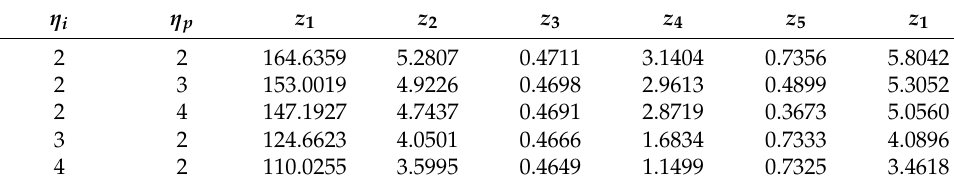
Table 3. Dependence of z 1 , . . . , z 6 on parameters of the integral terms